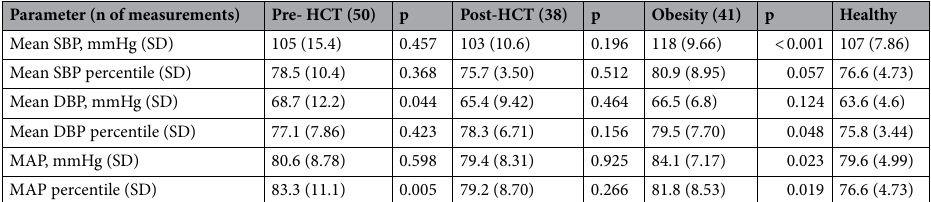
Table 4. ABPM parameters in the pre-HCT group the post-HCT group, and the obesity control group, compared with the healthy control